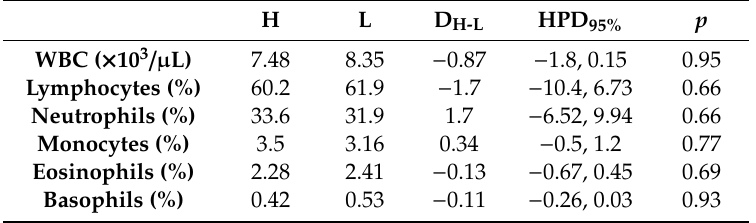
Table 2. Immune parameters in female rabbits from the high and the low line.